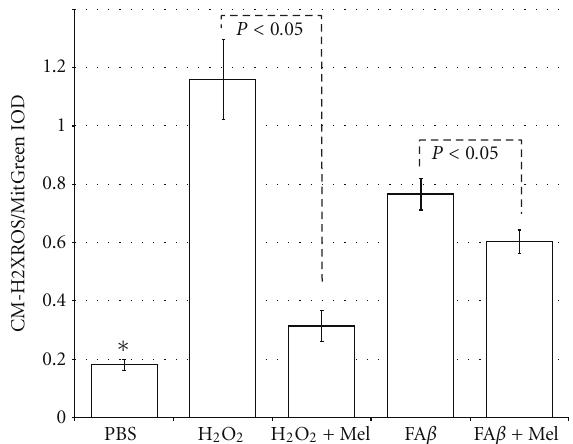
Figure 2: Compared with PBS-injected brains, those brains injected with A β or with H 2 O 2 had a significant increase in free radical levels in mitochondria, according to the CM-H2XROS/MitGreen quotient ( ∗ P < 0 . 05 versus all the other groups). However, by using melatonin a significant decrease in mitochondrial free radicals was observed both in A β - and in H 2 O 2 -injected brains.